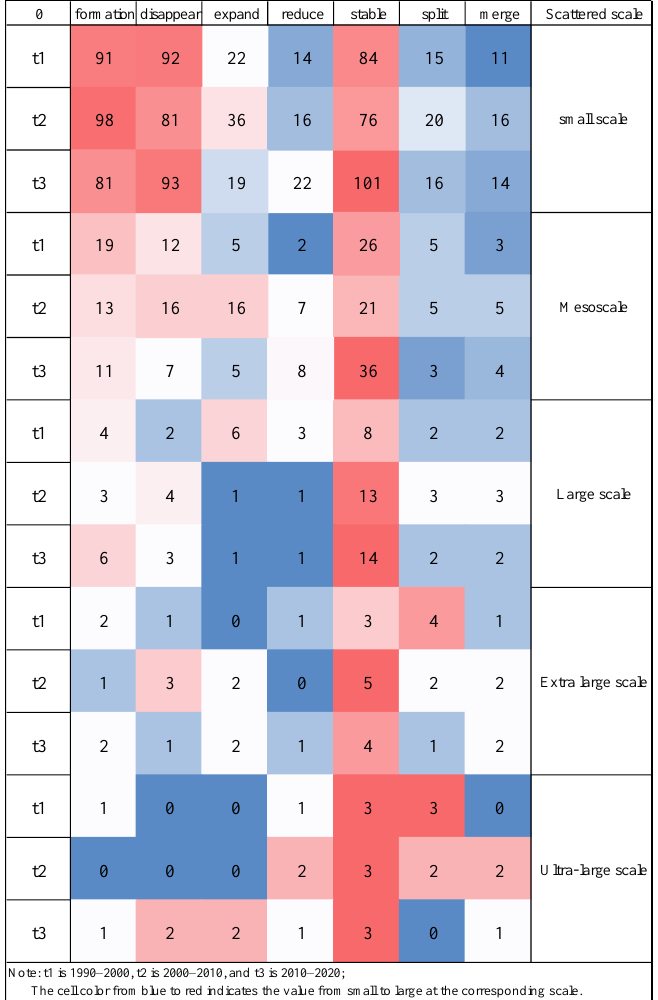
Figure 9. Number of evolutionary events of various ecological groups. Taking the small-scale ecological network as an example, the evolutionary events of the formation and disappearance of ecological groups mainly occurred at the urban – rural junction of Jiangmen City and Huizhou City. Human activities have a great influence, causing the core nodes of ecological groups to change frequently, and ecological groups cannot find effective precursor or successor ecological groups, resulting in the continuous formation of new ecological groups and the disappearance of old ecological groups. The Hong Kong – Shenzhen Dapeng ecological group is composed of core nodes in Shenzhen and Hong Kong, and large ecological sources are connected together in patches, with good connectivity between ecological sources. During the period from 1990 to 2020, the group experienced evolutionary events, such as ecological group expansion, stability and divi- sion. During the period from 1990 to 2010, the development trend of the Hong Kong – Shenzhen Dapeng ecological group was good, and the number of core nodes in the group increased, the range and area tended to be stable, but during the period from 2010 to 2020, the connection between the internal nodes of the ecological group and the peripheral eco- logical space nodes weakened, and they gradually separated into independent ecological groups, resulting in the split of ecological groups.